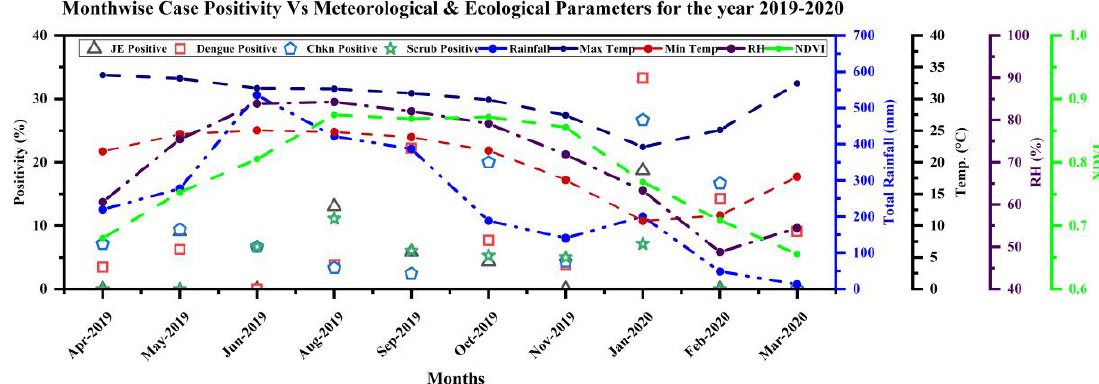
Figure 5. Variation in monthly meteorological parameters during the study period. The temperature and relative humidity data were taken from NASA’s MERRA-2 model. The used products are the daily maximum (T2MMAX), minimum (T2MMIN), average temperature (T2MMEAN), and relative humidity. Month-wise sample positivity for Dengue, Chikungunya, JE, Scrub Typhus diseases were plotted on the X-axis to examine the relationship with the meteorological parameters at the time cases were identified. The yearlong transmission for all the diseases with relatively high positivity rate in dry winter months was seen. MERRA = Modern-Era Retrospective analysis for Research and Applications, JE = Japanese Encephalitis.